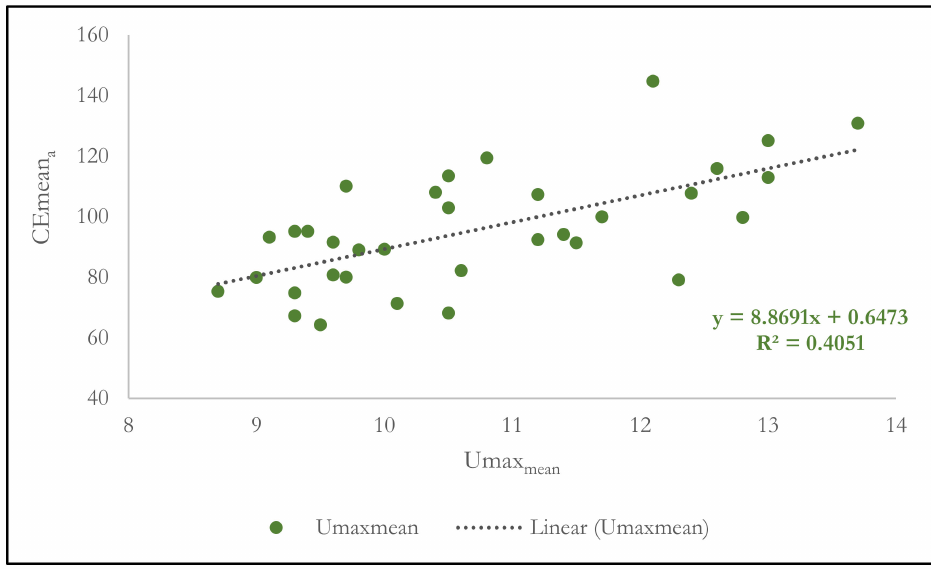
Figure 15. Relationship between CEmean a and Umax mean during study